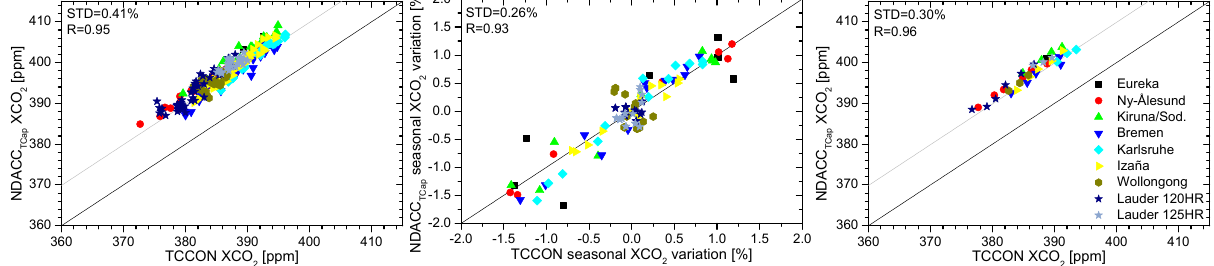
Fig. 6. As Fig. 5 but for NDACC XCO 2 applying the varying TCCON a priori (NDACC TCap ) vs. TCCON. The black line represents the one-to-one correlation, the grey line is the correlation shifted by 2.5%.